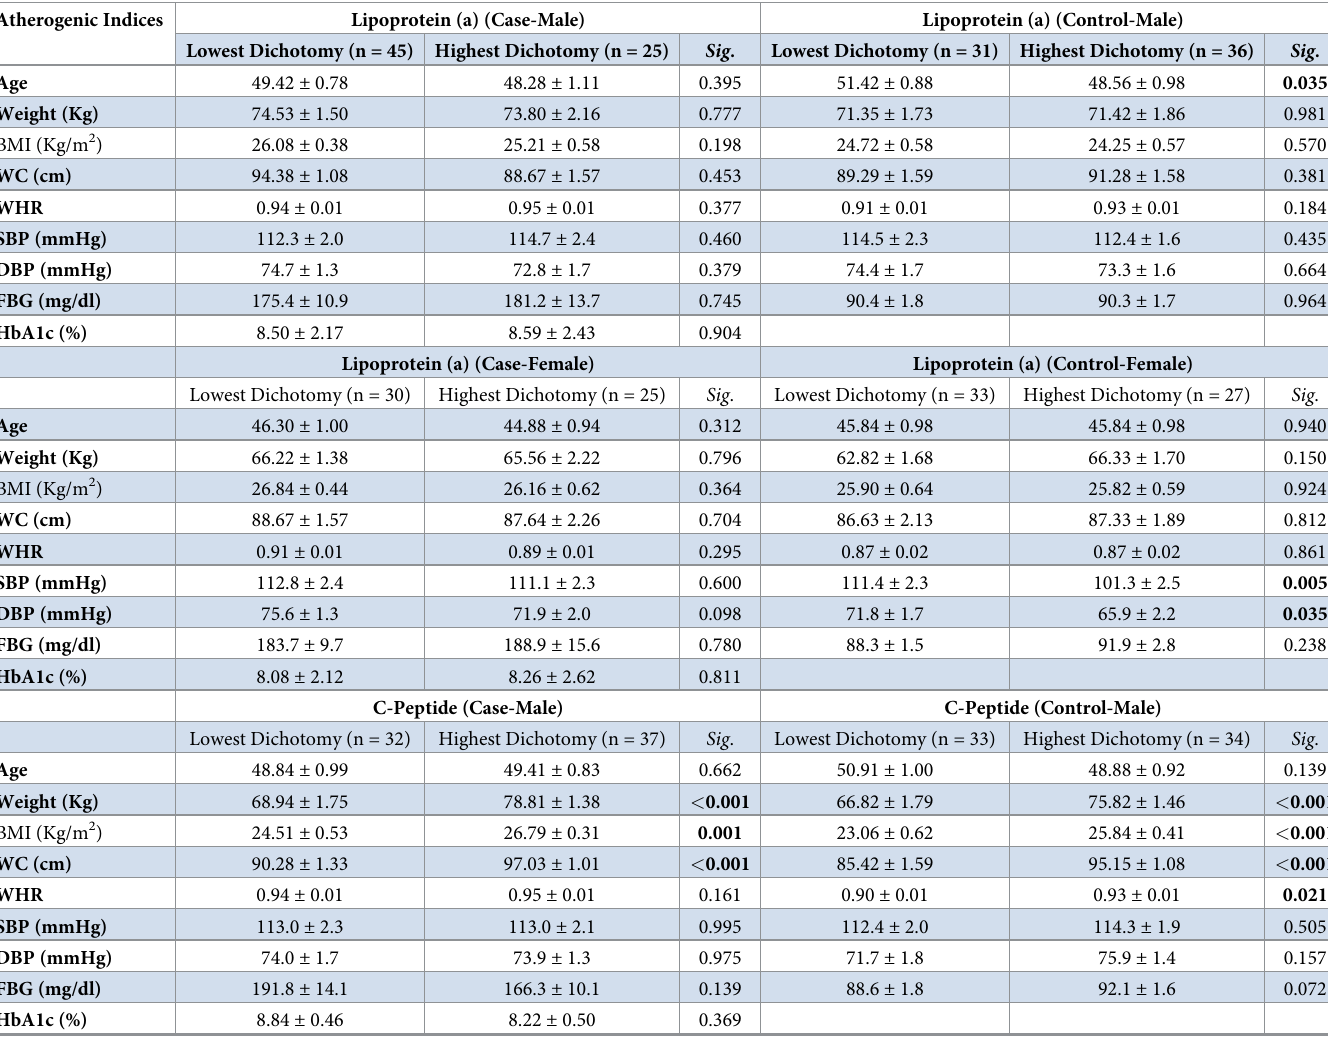
Table 6. Mean ± SE � of cardiometabolic biomarkers‡ of plasma according to dichotomizing of lipoprotein (a) and C-Peptide levels. Atherogenic